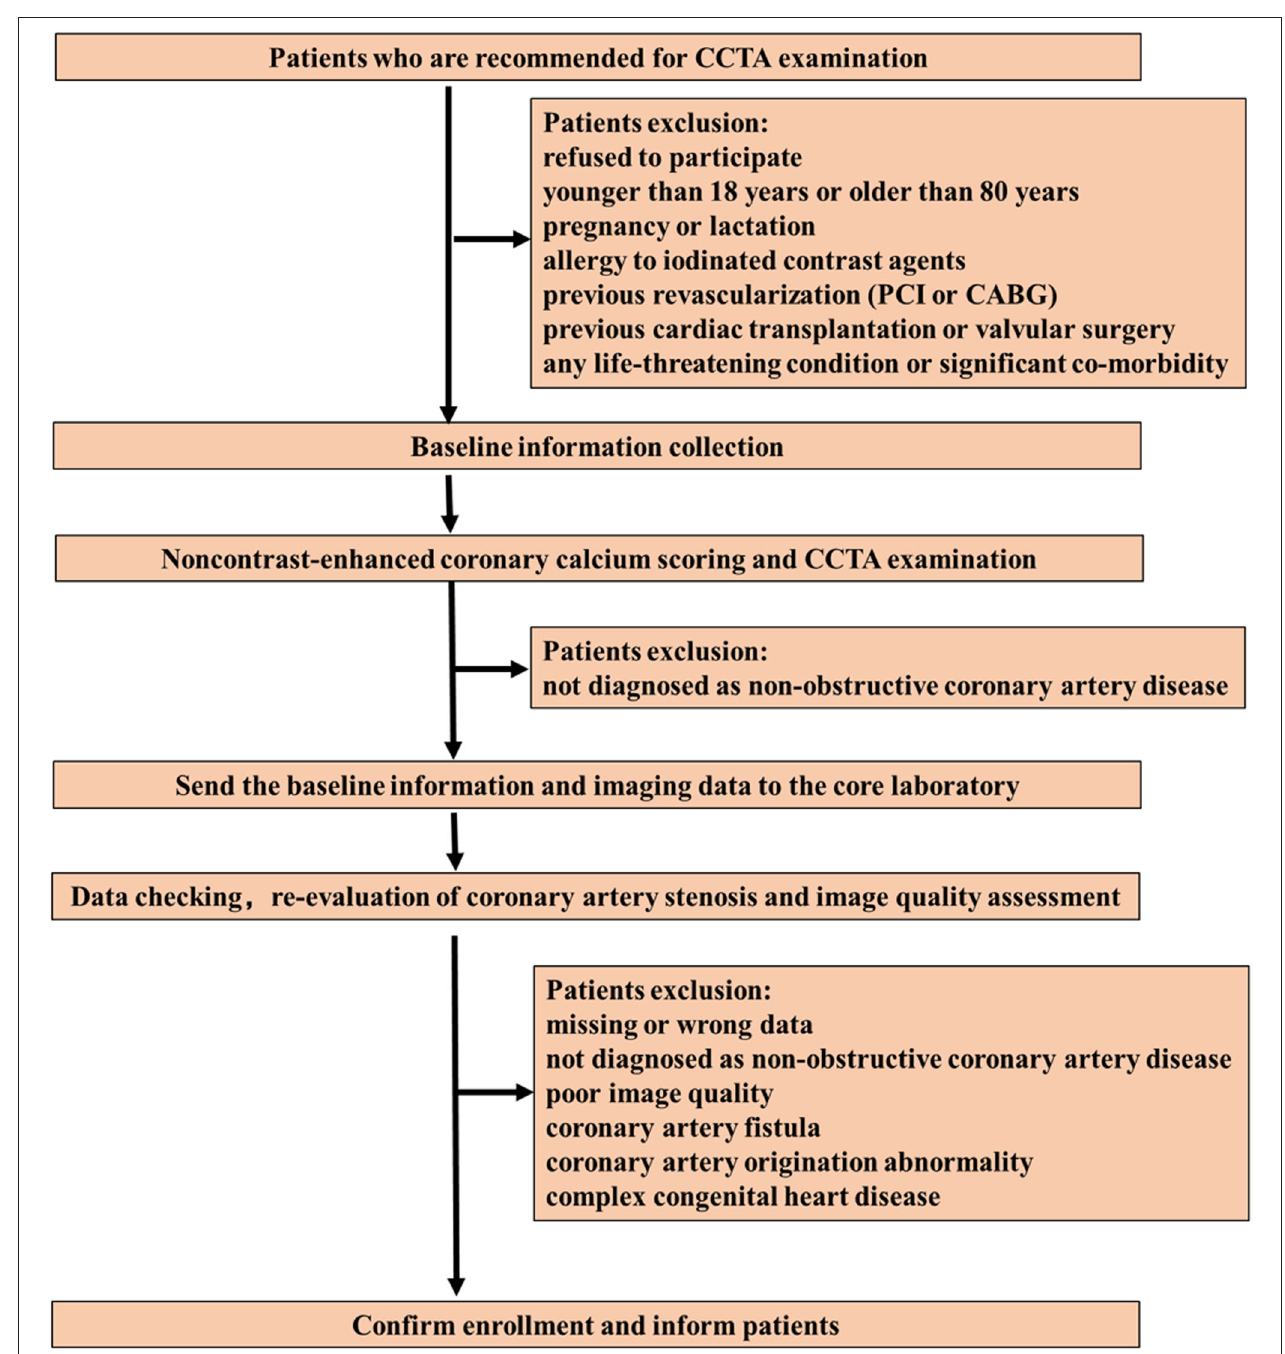
FIGURE 1 | Patient enrollment flow chart. CCTA, coronary computed tomography angiography; PCI, percutaneous coronary intervention; CABG, coronary artery bypass grafting.